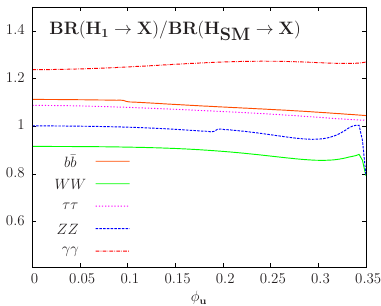
Figure 6. H 1 and H 2 masses (in GeV) in the C –NMSSM scenario described in the text as a function of the phase φ u . Figure 7. The ratio between H 1 decay branching fractions in the C –NMSSM and the SM predictions for the same mass as a function of the phase φ u .